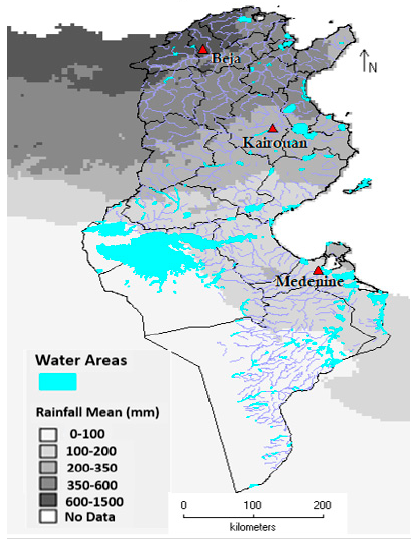
Figure 1. Location of field trial sites in different agro-climatic zones of Tunisia.